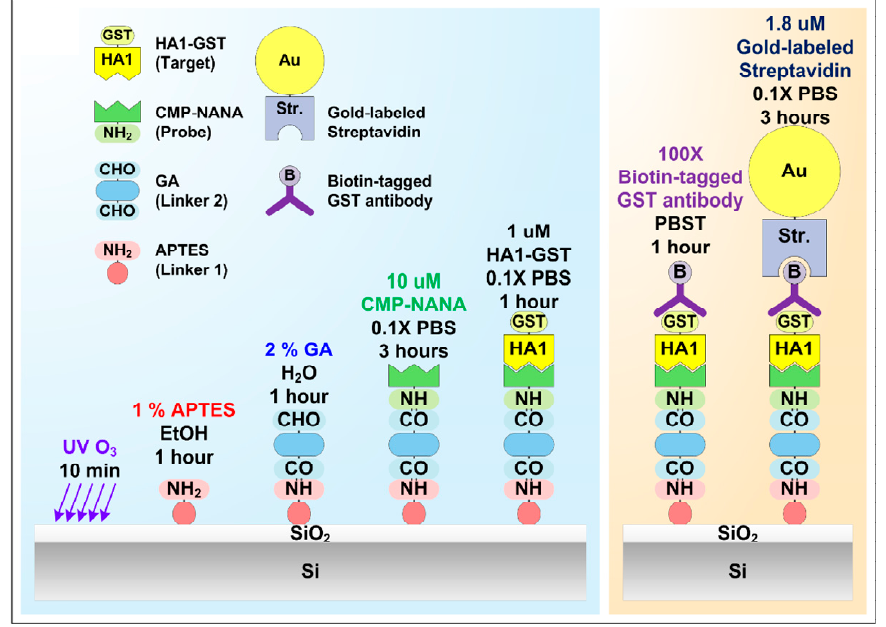
Figure 5. Scheme of the surface functionalization and immobilization of CMP-NANA and HA1 (left panel) and the preparation for tagging HA1 with gold nanoparticles for SEM analysis (right panel).